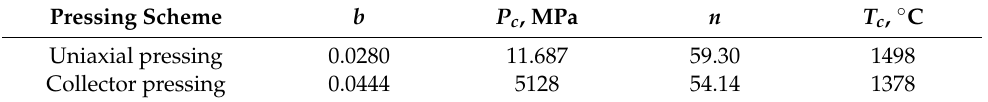
Table 1. Rheological characteristics of the sintered ceramics under spark plasma sintering (SPS) conditions.